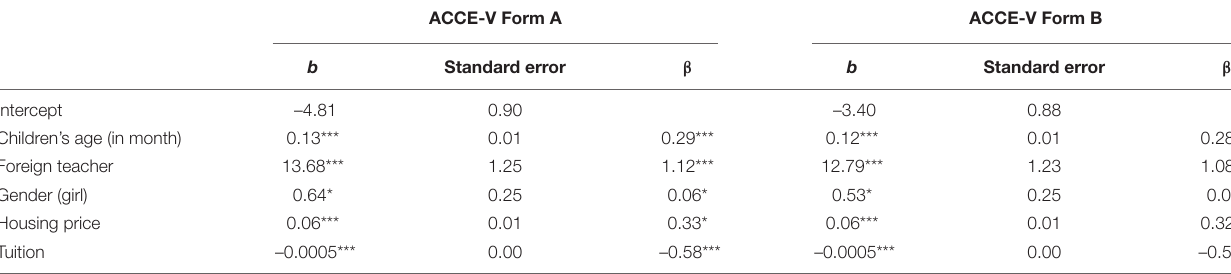
TABLE 8 | Results of multiple linear regression models predicting the ACCE-V